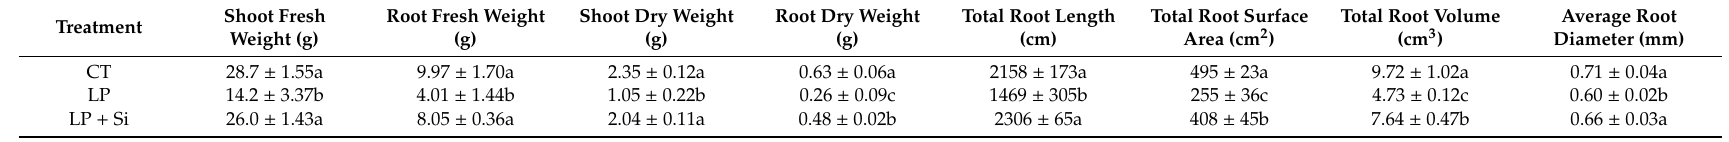
Table 1. E ff ect of exogenous silicon on plant biomass and root morphological traits of tomato plants under deficit phosphorus supply.